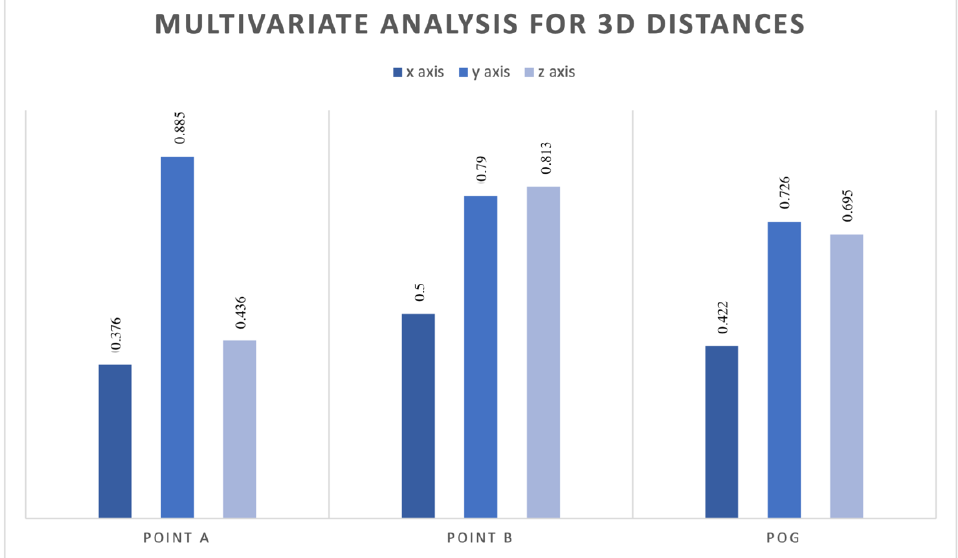
Figure 7. Multivariate analysis to investigate the influence of each axis on the overall 3D distance for the selected cephalometric